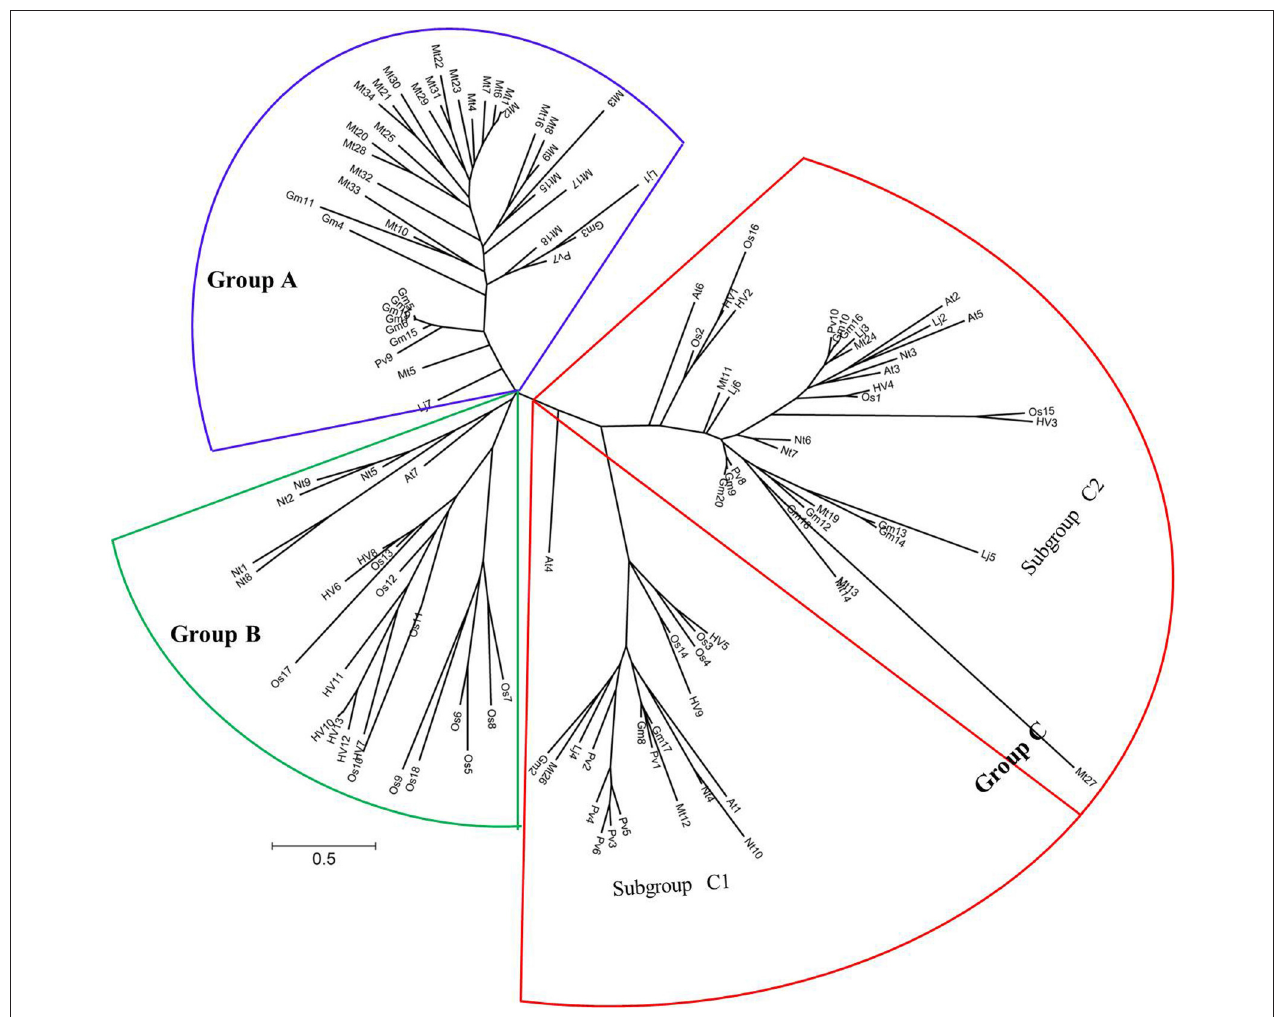
FIGURE 3 | Phylogenetic tree of cystatin proteins from soybean, M. trunctula , L. japonicus , common bean, A. thaliana, N. tabacum , rice and barley. Twenty cystatin proteins from soybean, 34 cystatin proteins from M. trunctula , 7 cystatin proteins from L. japonicus , 10 cystatin proteins from common bean, 7 cystatin proteins from A. thaliana , 10 cystatin proteins from N. tabacum , 18 cystatin proteins from rice, and 13 cystatin proteins from barley were used to construct the phylogenetic tree using the programs RAxML and MEGA6.0. These cystatin proteins were classified into three groups, namely Group A, Group B, and Group C. Group C was subdivided in two subgroups: subgroup C1 and subgroup C2. GenBank accession numbers of these cystatin proteins are listed in Table S1.